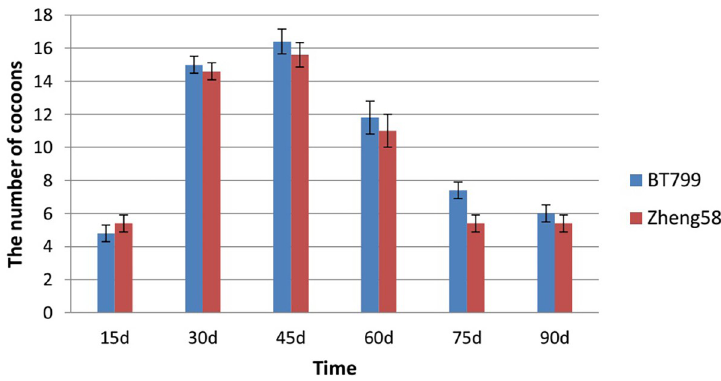
Fig 3. Effects of Bt maize on the number of cocoons produced by E . fetida . Values are means ± SE, n = 5.